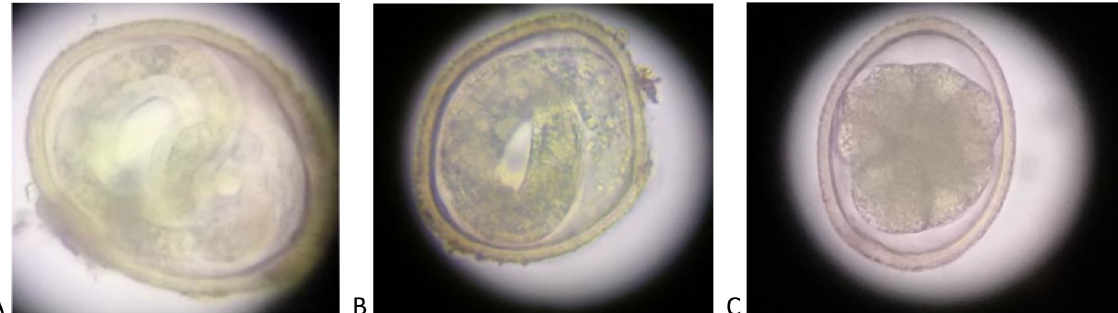
Fig 1. Toxocara forms isolated in NYC specimens: a and b: Larvated ‘infective’ Toxocara eggs at 40x magnification, c: Unlarvated Toxocara egg at 40 x magnification, obtained in NYC study.